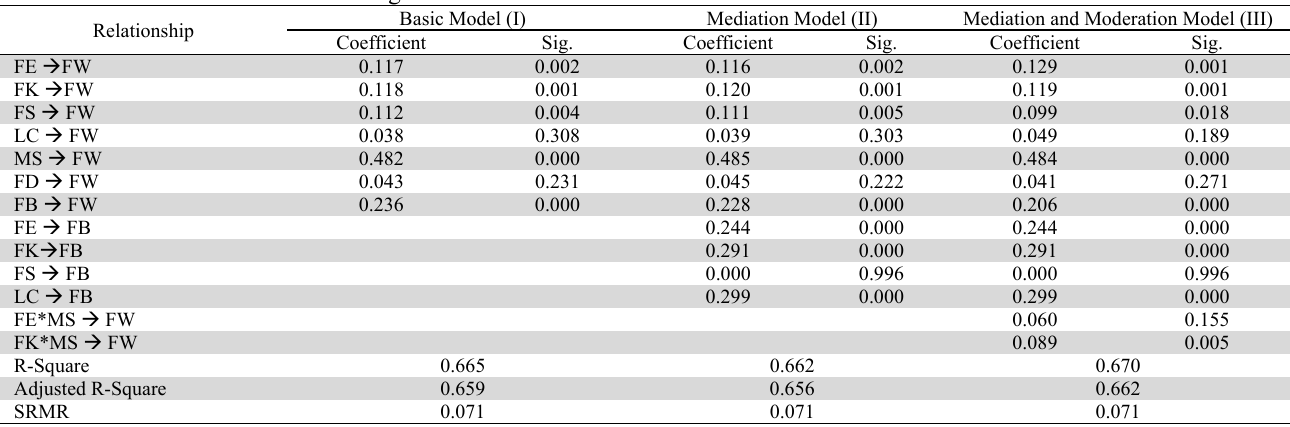
The Results of the Financial Well-being Model